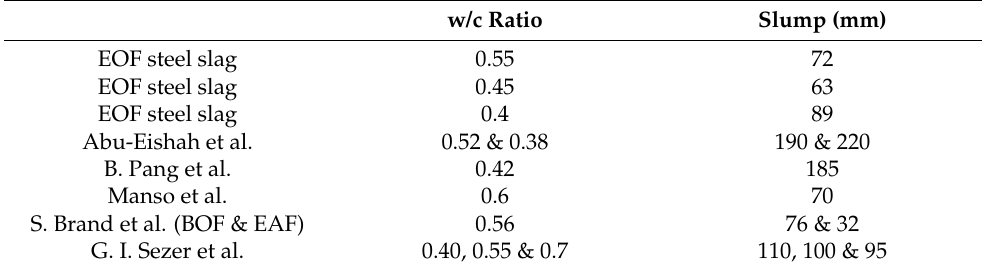
Table 7. Workability of concrete comprising EOF steel